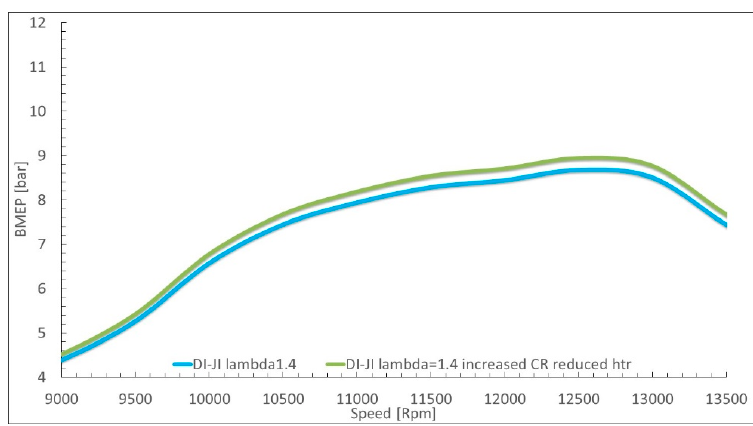
Figure 13. BMEP of lean burn engines.